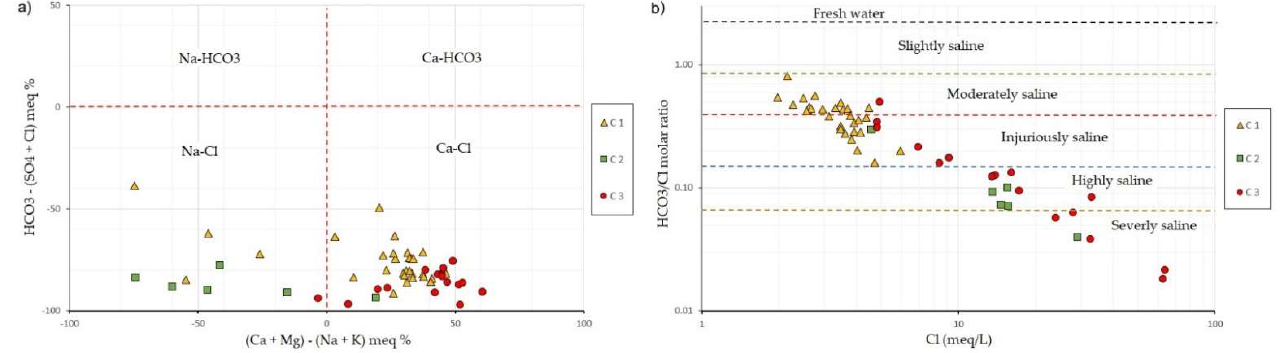
Figure 8. ( a ) Chadha diagram. ( b ) Simpson’s degrees of salinization.